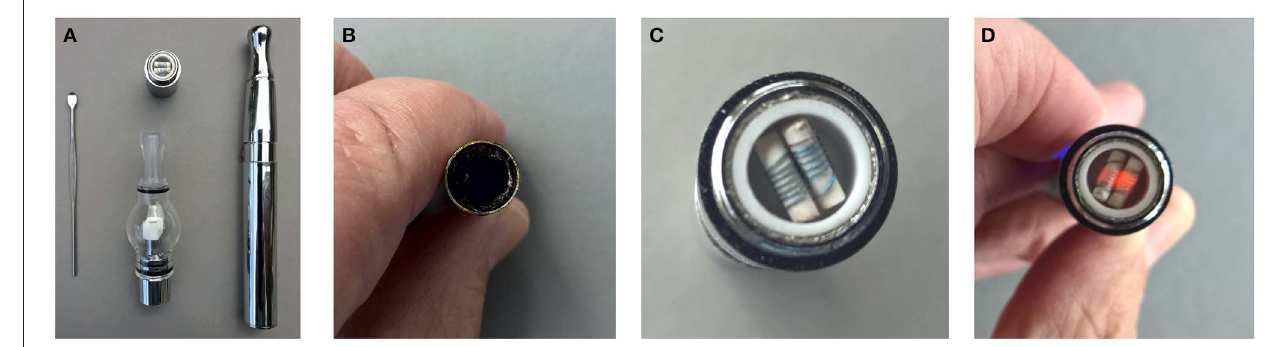
FIGURE 2 | Demonstration of a “vape-pen.” (A) Vape-pen unit (B) “Wax” in unit (C) Unheated coil (D) Coil becomes red hot in seconds after actuation.